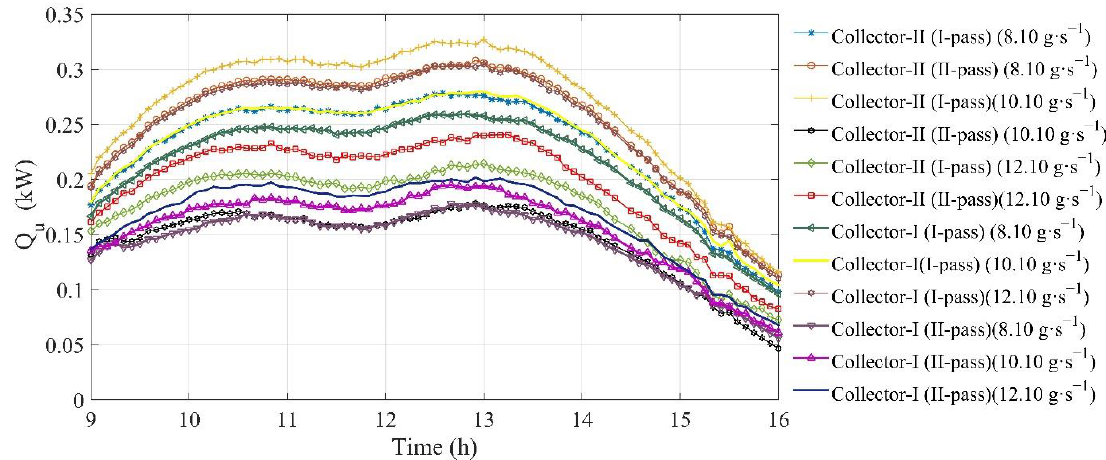
Figure 4. The useful heat gain rate of the air in the two-pass solar collector.